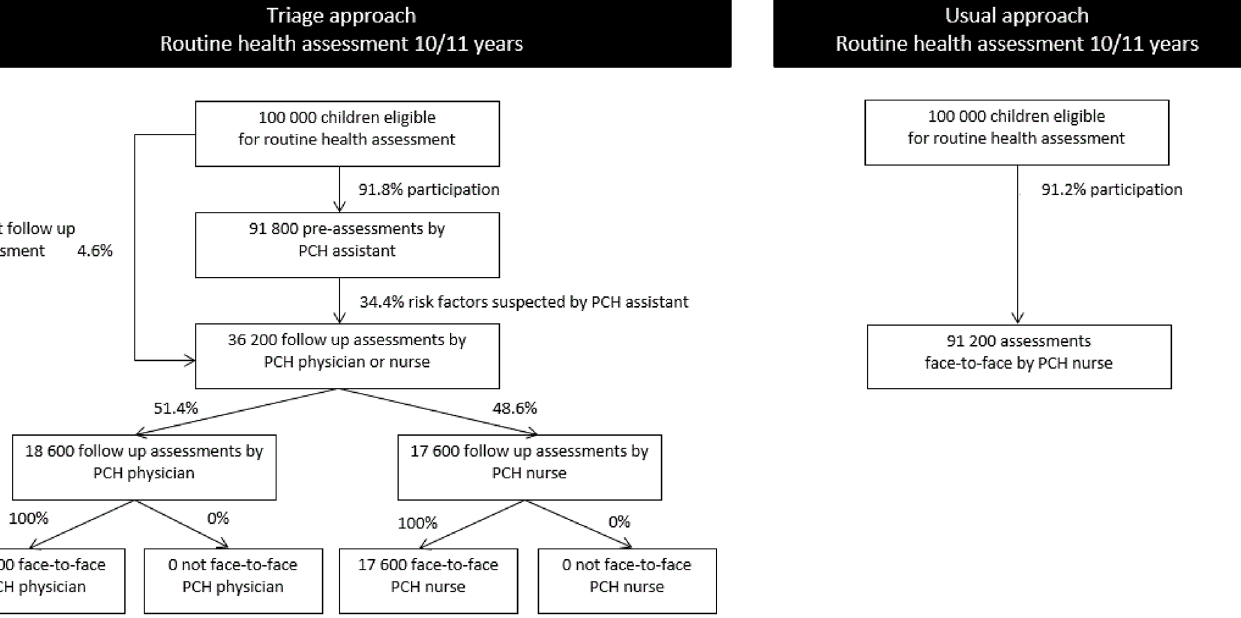
PLOS ONE | https://doi.org/10.1371/journal.pone.0176569 April 26,